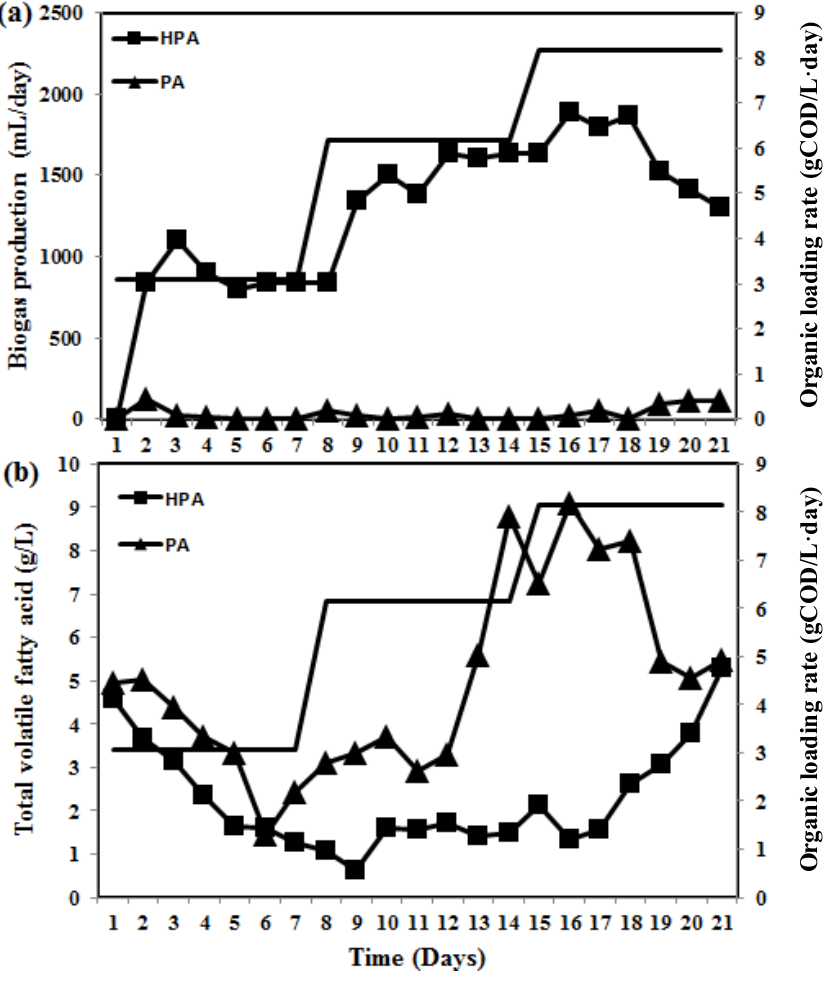
Figure 5. Efficacy of PA and HPA in compact MMBR: ( a ) Daily biogas volume produced; ( b ) Total volatile fatty acids. The ramped solid lines indicate the organic loading rate and the symbols show the biogas production and total volatile fatty acids in ( a ) and ( b )